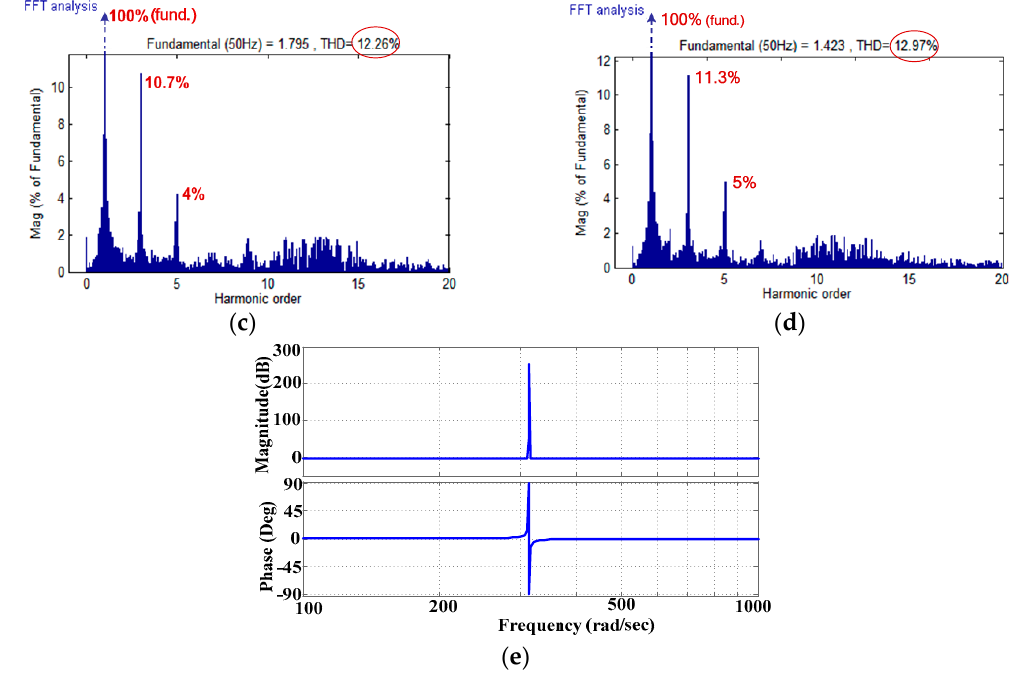
Figure 8. Zoom into system performance applying CPRC; CSI grid current, and grid current with its fast Fourier transform (FFT) analysis at ( a , c ) high power level, and ( b , d ), low power level, and ( e ) Bode plot.